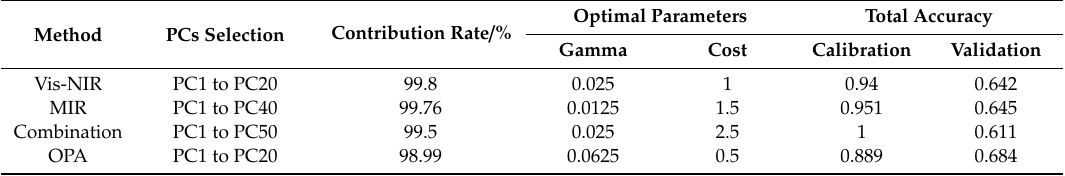
Table 3. Parameter optimization for a support vector machine (SVM) and prediction result statistics for calibration and validation sets.